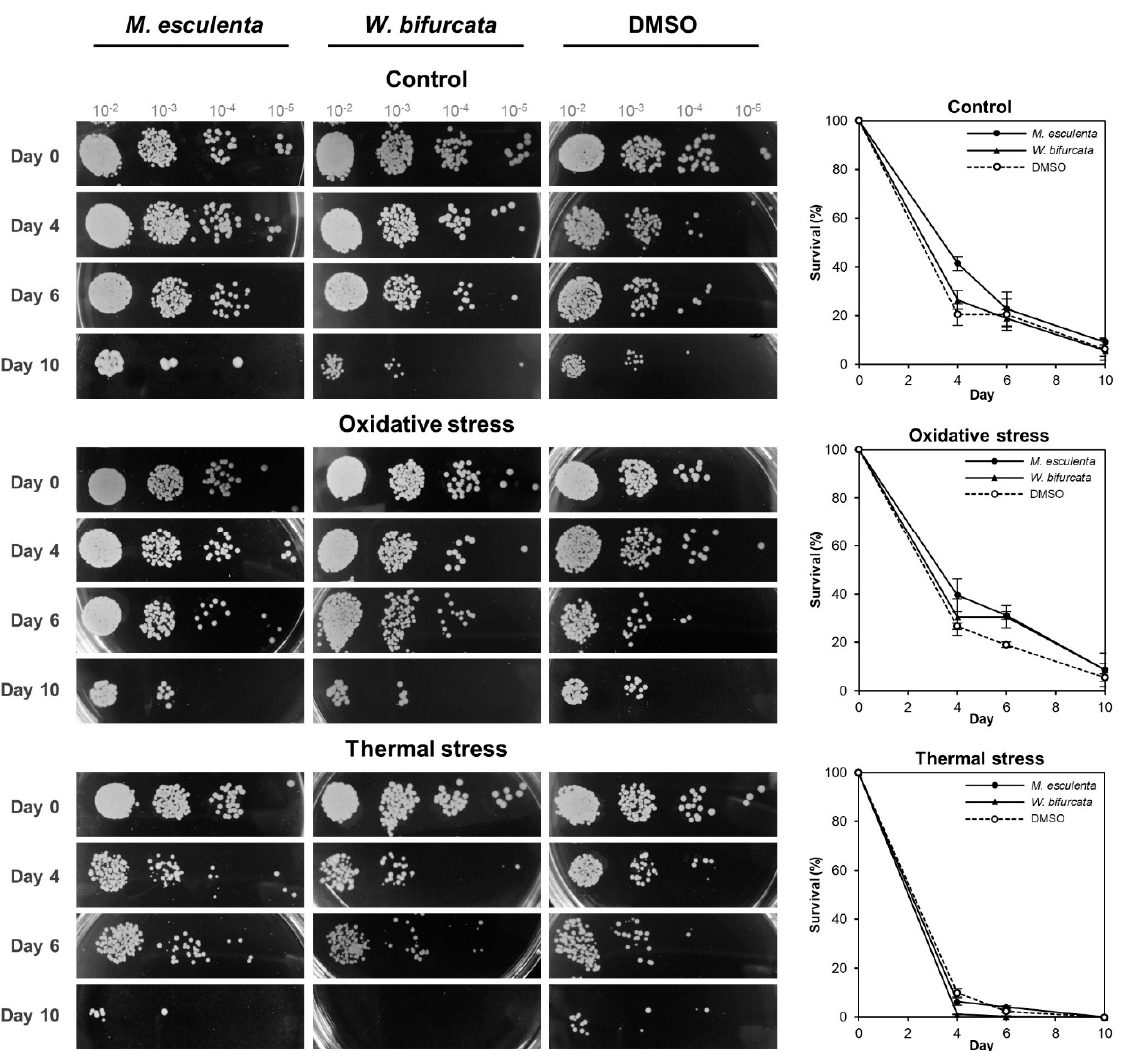
Figure 3. Oxidative and thermal stress responses of PEs-treated yeast and control yeast during chronological ageing. Yeast cultures of strain 1783 treated with M. esculenta or W. bifurcata leaf extract at optimal final concentrations of 50 μ g/mL and 10 μ g/mL, respectively, or DMSO control were chronologically aged in Bijou bottles until day 10. At each age point, a small volume of yeast cells was transferred out of the ageing culture and was exposed to oxidative stress by being treated with 3 mM H 2 O 2 for 1 h at 30 °C or thermal stress at 55 °C for 20 min before being spotted in 10-fold serial dilutions (10 − 2 , 10 − 3 , 10 − 4 , 10 − 5 ) on YPD agar. Quantitative outgrowth CLS analysis was carried out simultaneously to determine the survival of cultures aged with M. esculenta or W. bifurcata leaf extracts after oxidative and thermal stress exposure. An aliquot of each non- or stress-treated culture was transferred to a 96-well microplate containing YPD medium for outgrowth on day 0, 4, 6 and 10. The survival percentages of the cultures were derived from the outgrowth curves (Supplementary Figure S12). Error bars represent the SEM of at least three (three to six) biological replicates.